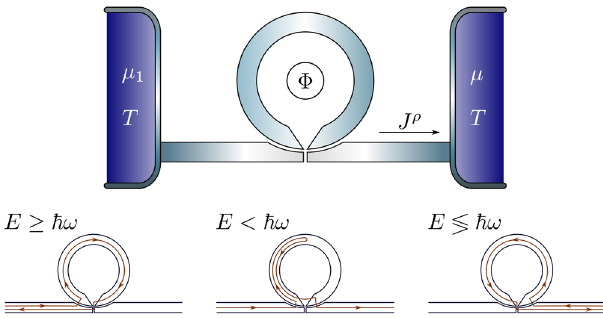
FIG. 2. Quantum generator. A mesoscopic ring is connected to two leads via a four-way beam splitter such that, without a magnetic flux, all incoming carriers are reflected after passing through the ring. The current J ρ is generated by changing the magnetic flux Φ such that clockwise-moving carriers are decel- erated by the emerging electromagnetic force around the ring. As a result, incoming carriers from the left are reflected only if their energy E is above the threshold ℏ ω , which is required to pass through the entire loop; carriers with E < ℏ ω are flipped around and transmitted to the right. At the same time, carriers coming from the right are accelerated and thus reflected regardless of their